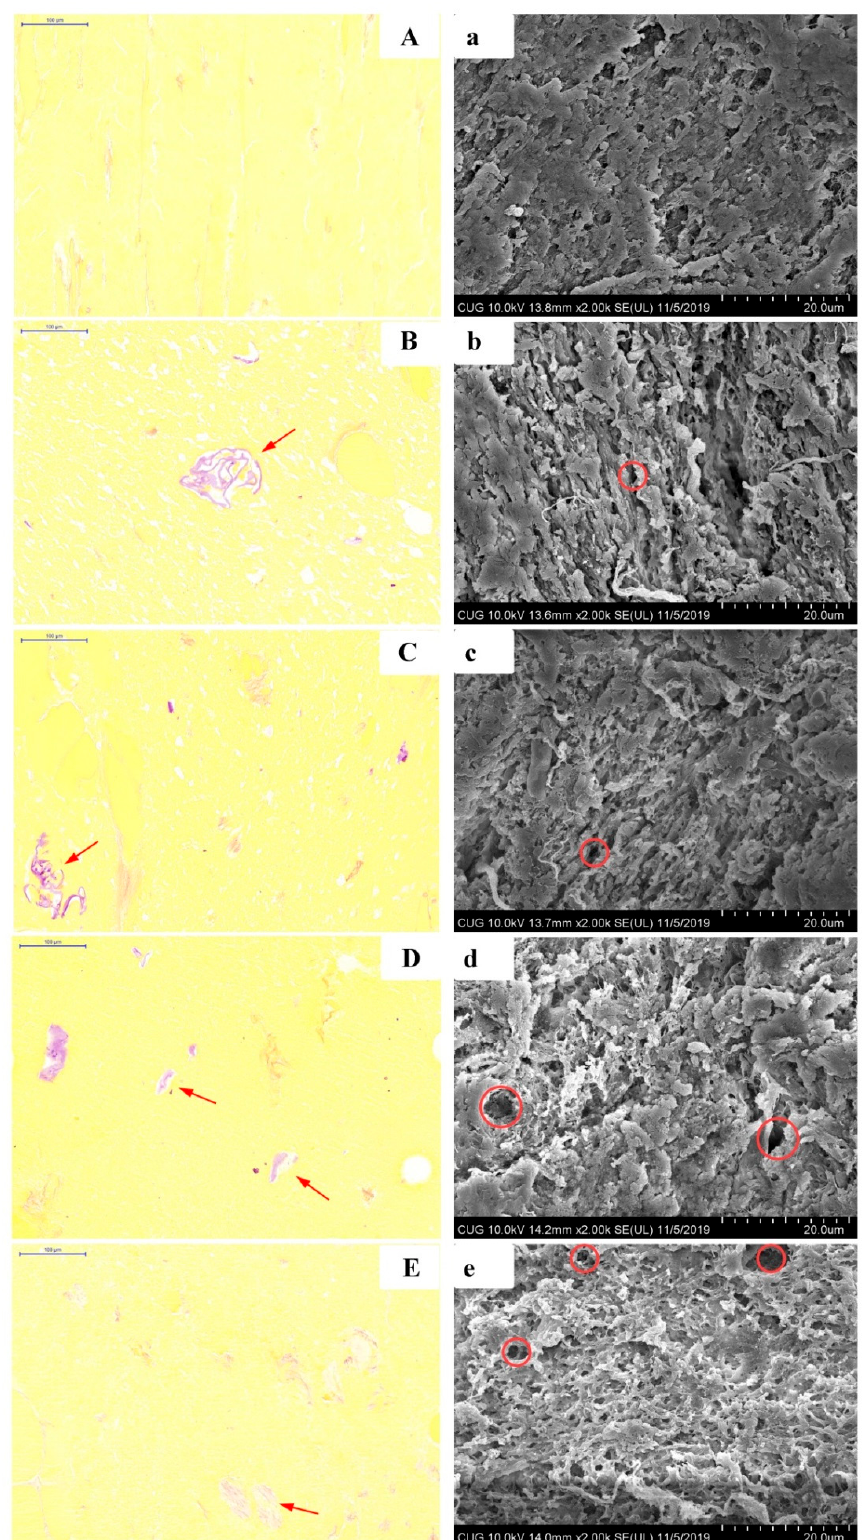
Figure 2. Light microscopy images ( A – E ) (20 × ) and scanning electron microscope images ( a – e ) (2000 × ) of surimi gels with different KGM enzymatic hydrolysates (KEH). ( A – E and a – e represented C, SK1, SK2, SK3, and SK4,